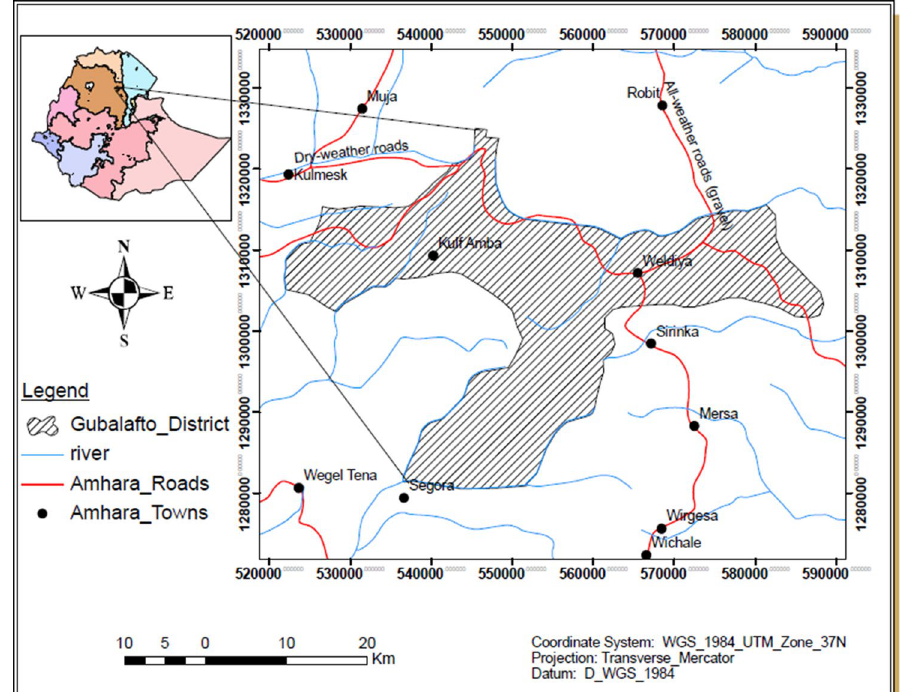
Fig. 1 A map showing location of the study